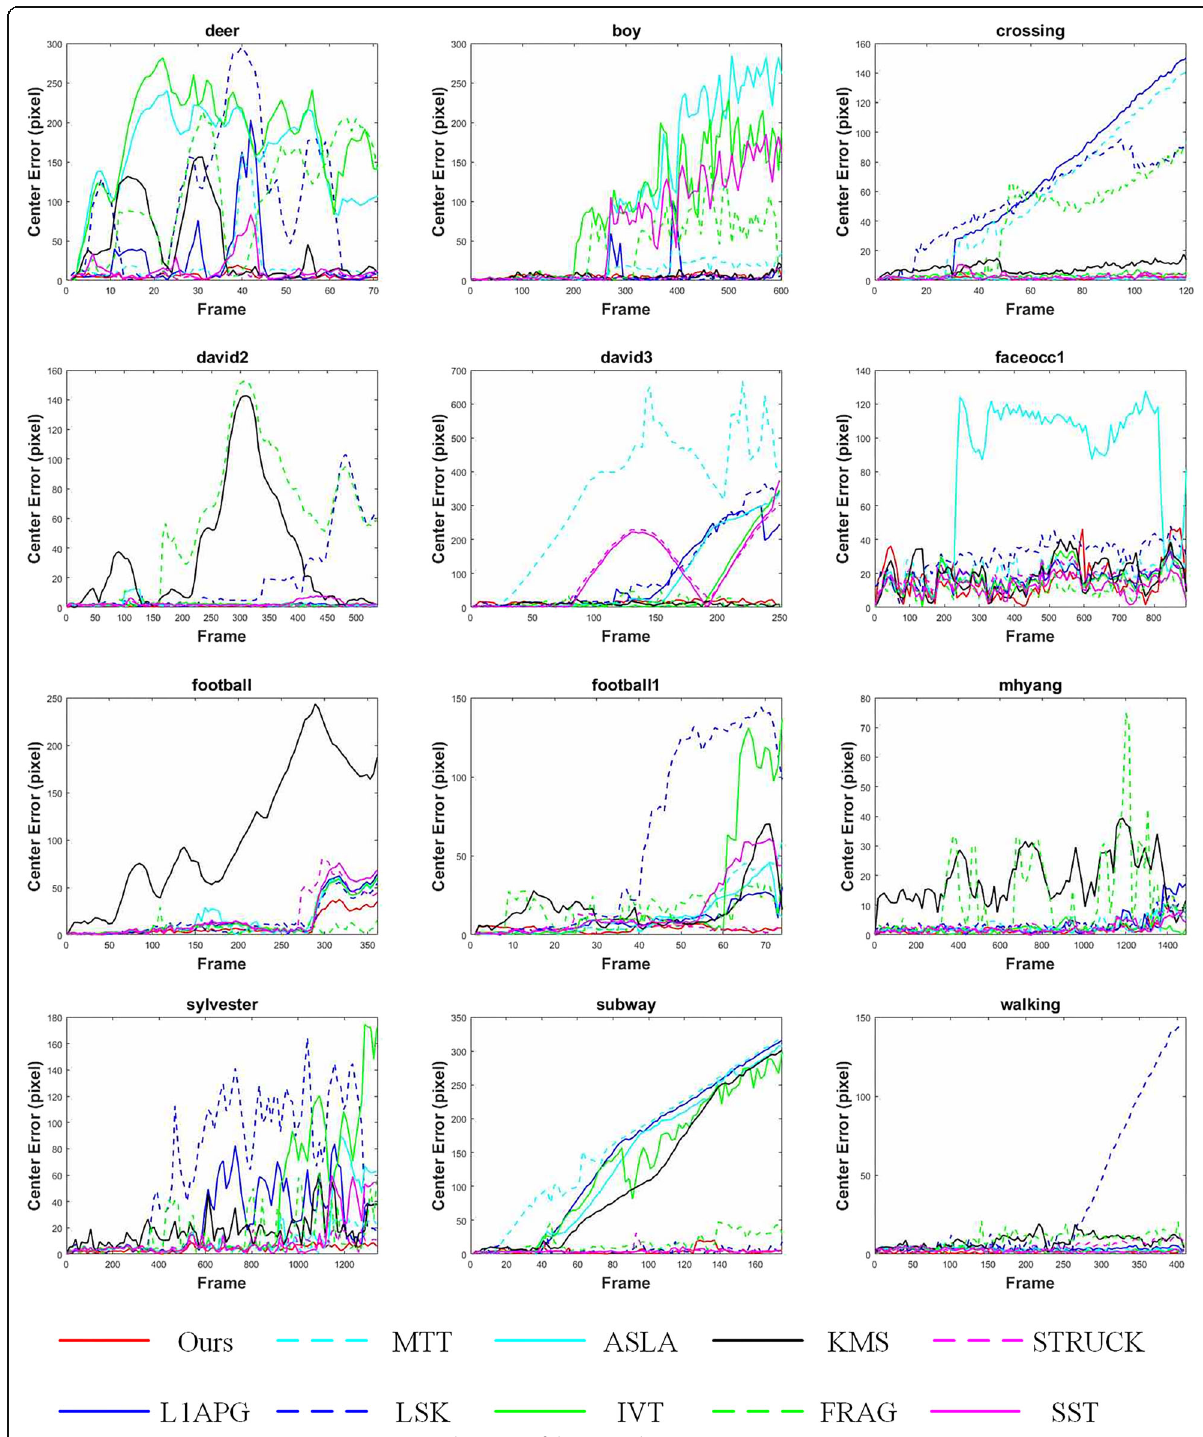
Fig. 3 Center error comparisons on 12 sequences with 9 state-of-the-art